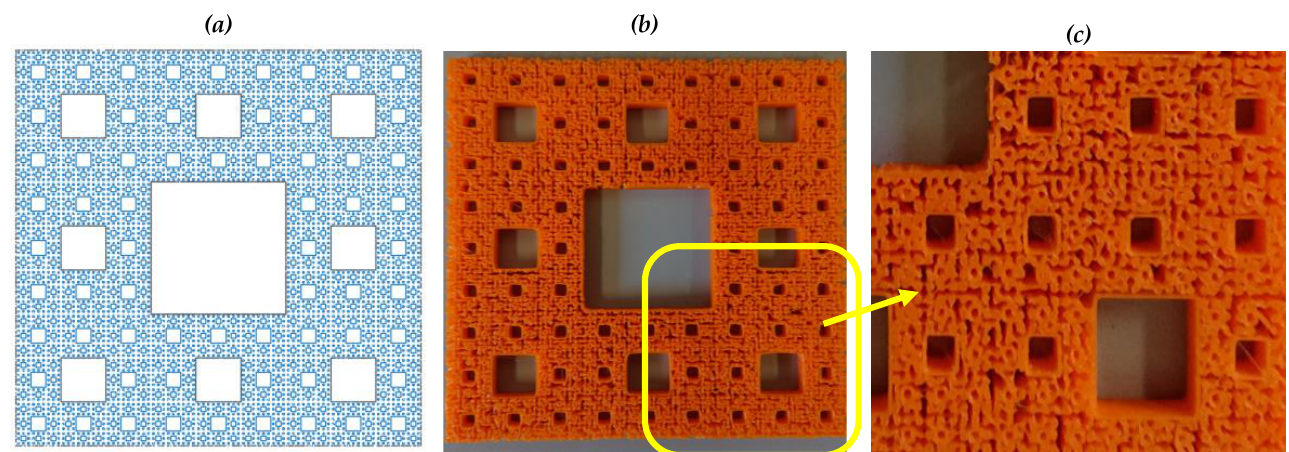
Figure 12. Point clouds controlled up to the fifth level and the 3D-printed porous structure: ( a ) point clouds; ( b ) 3D-printed porous structure; and ( c ) a magnified view of the printed structure.